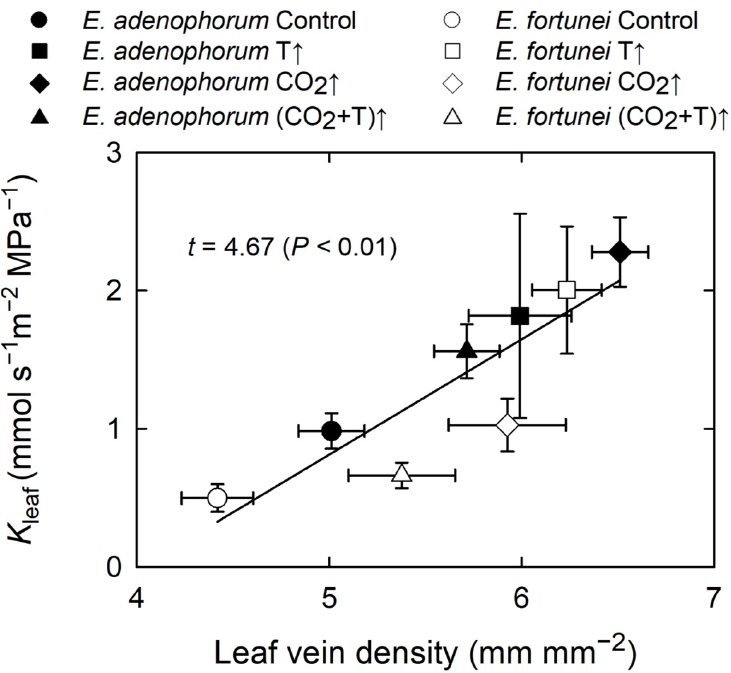
Figure 8. The relationship between leaf vein density and leaf hydraulic conductance ( K leaf ) across species and treatments. A linear mixed model was fitted to the data with species as a random factor.